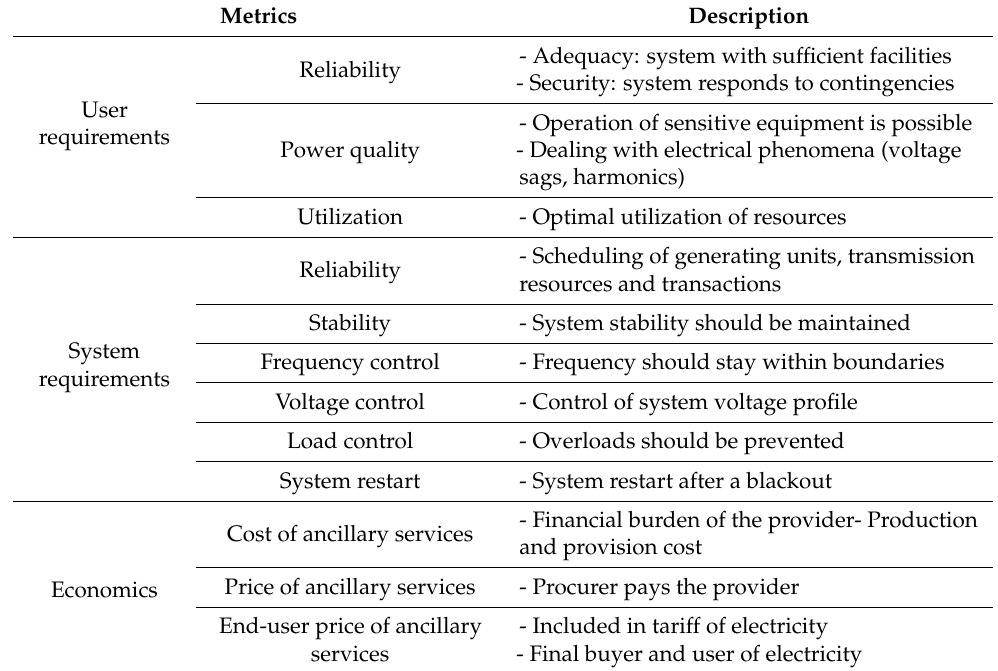
Table 7. Overview of reliability assessment metrics